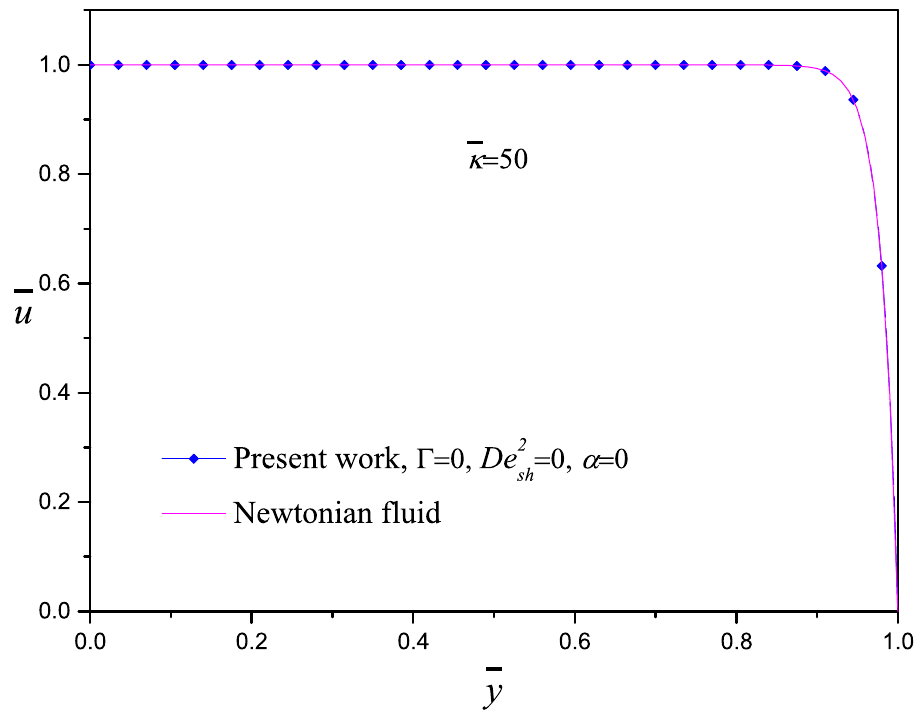
Figure 2. Comparison of the analytical solution and the approximate solution (present work) for an electroosmotic flow.